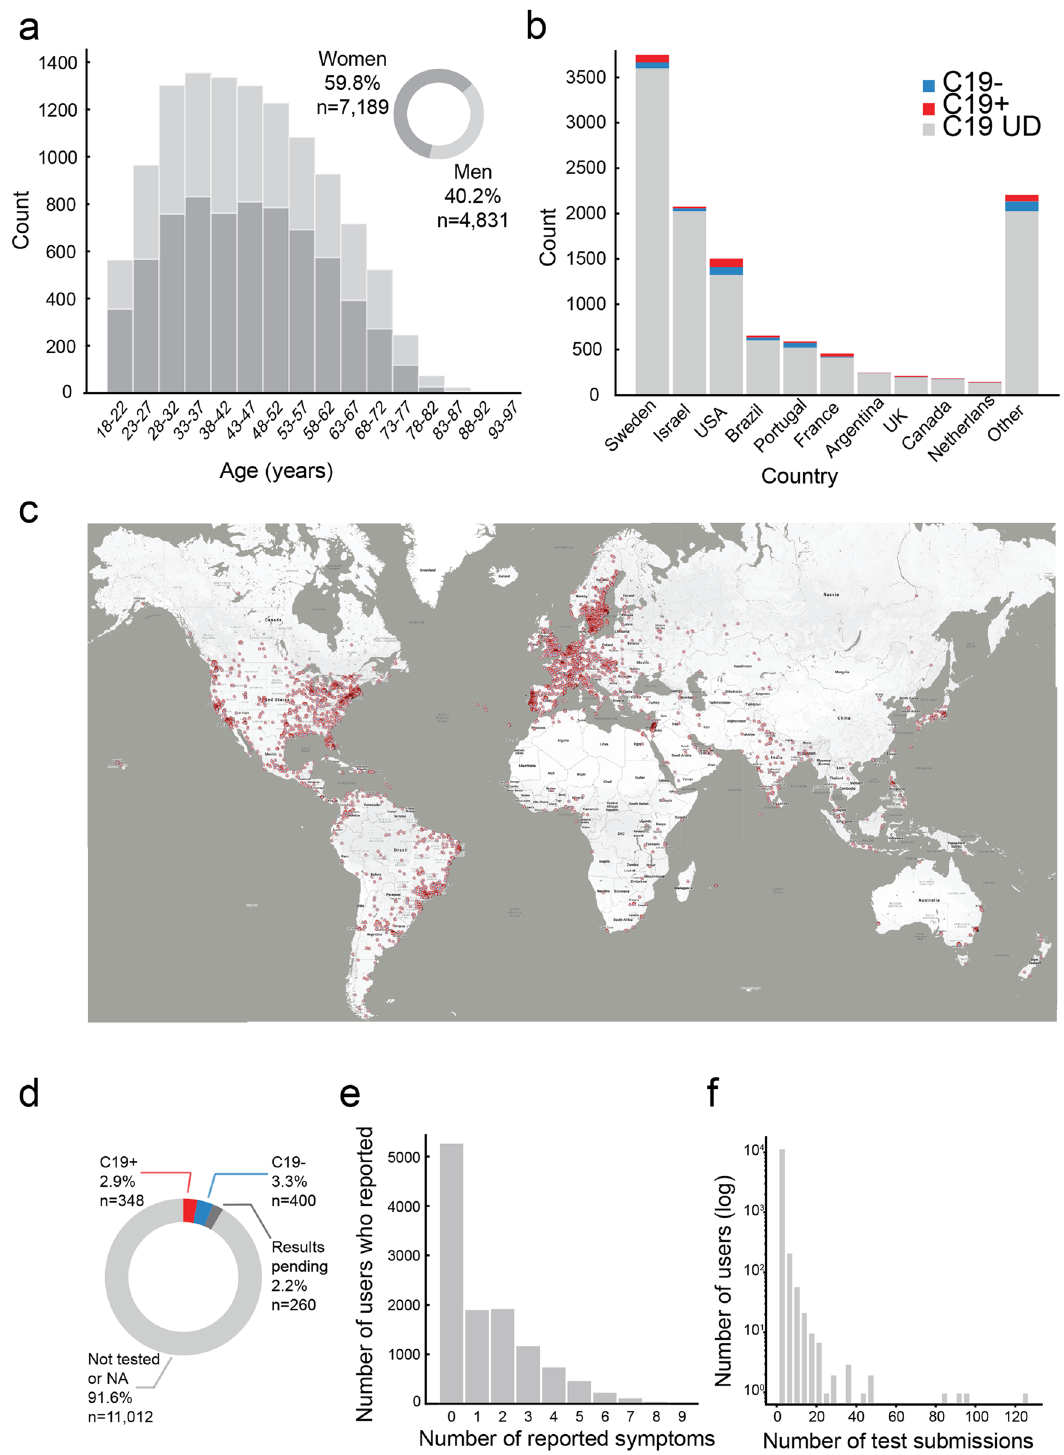
Fig. 1 Characterization of 12,020 participants. a Histogram of age and gender distribution of participants. b Histogram of number of participants and their COVID-19 status from the ten highest-participation countries (see comment on India in “ Methods ” section). c Map of geographical distribution of respondents, each dot is a participant, overlapping dots not shown to maintain clarity. d Pie chart of the distribution of C19 + , C19 − , and C19-UD in the sample. e Histogram of the distribution of number of somatic symptoms reported by participants. f Histogram of the distribution of number of submissions per